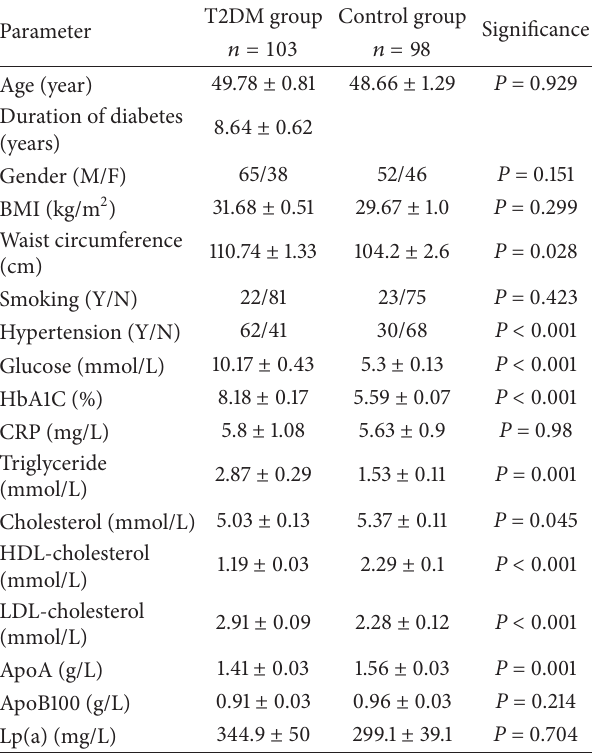
Table 1: Anthropometric and laboratory data of type 2 diabetics (T2DM) and control group of our study population.